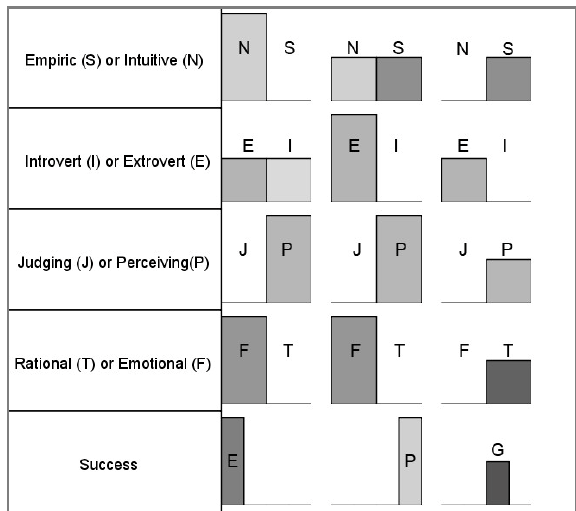
Fig. 4. Student profiles for course on Psychology